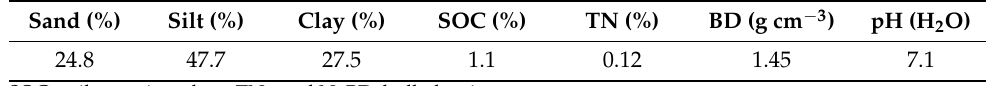
Table 1. The main soil properties in the 0–20 cm soil layer.